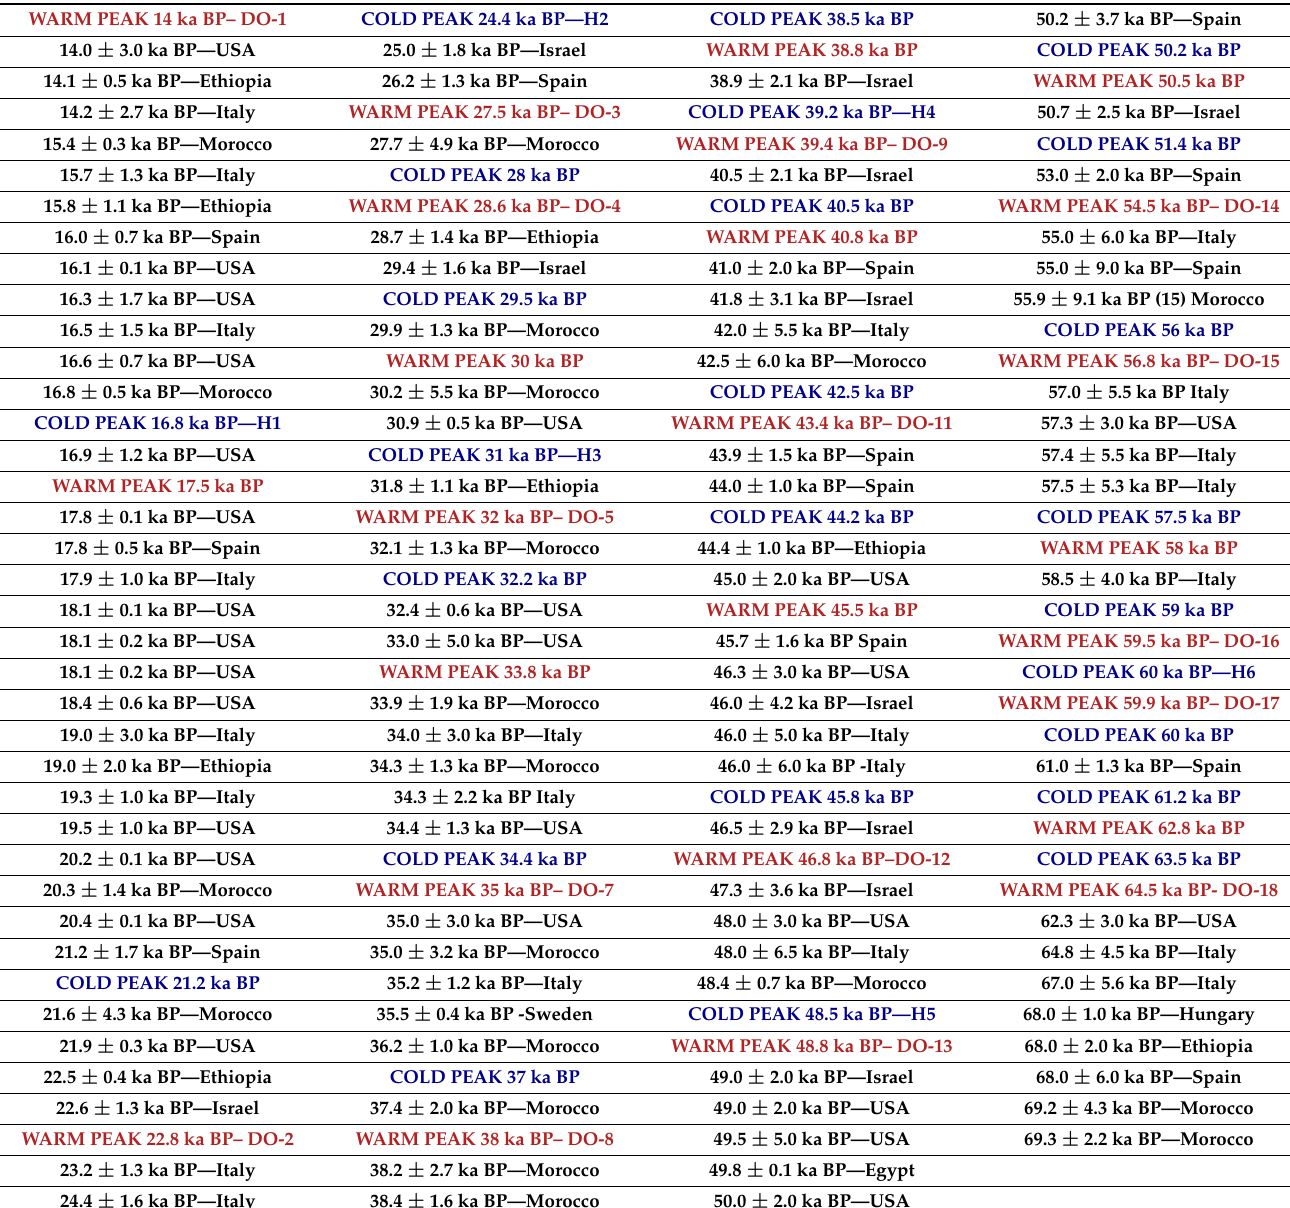
Table 1. U/Th dates of calcareous tufa deposits from different countries and cold/warm peaks in the MIS 2-3-4 chronological interval; modified from Fubelli et al., 2021